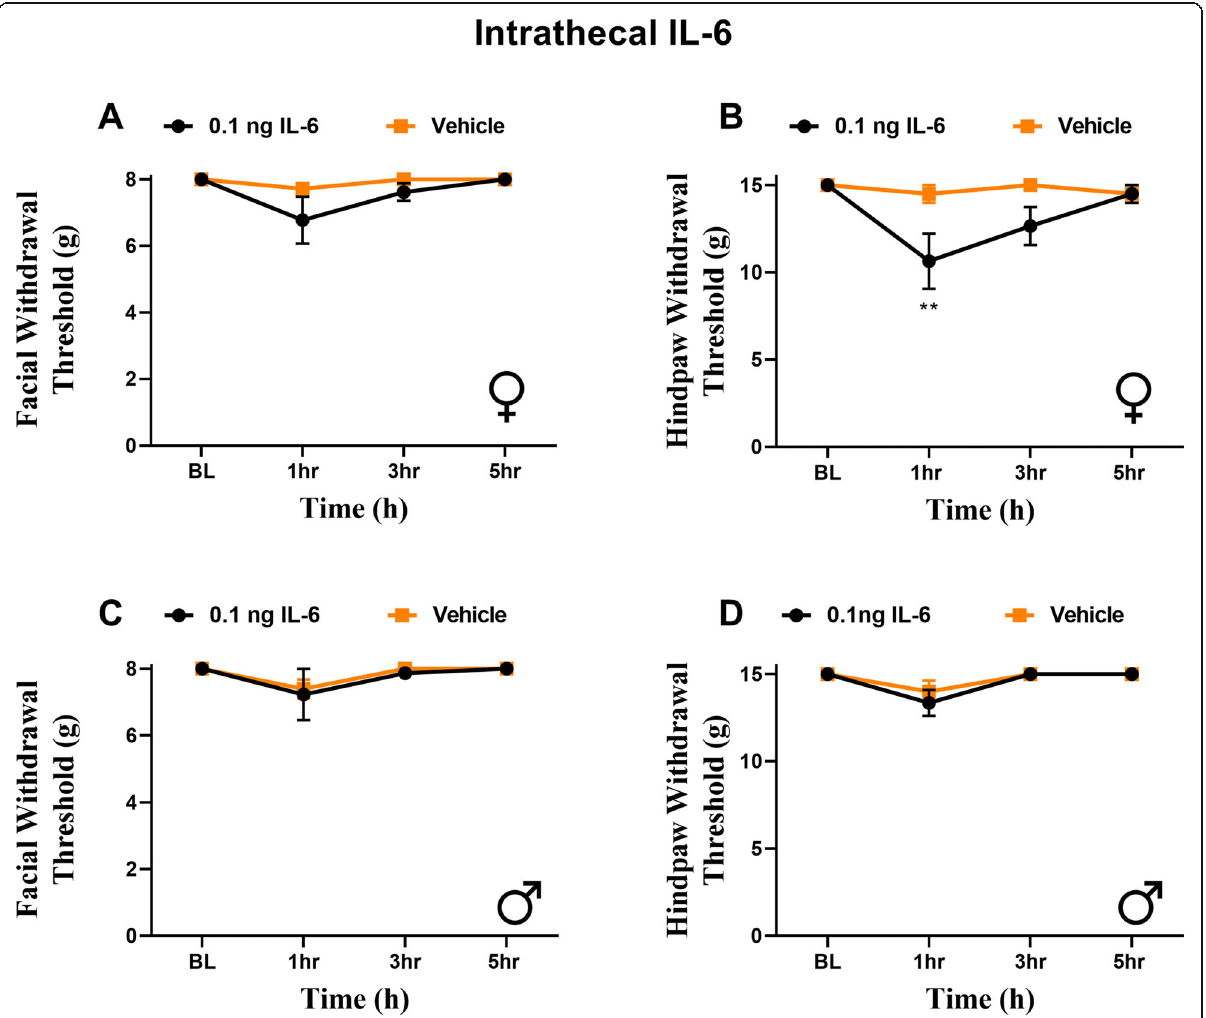
Fig. 7 Intrathecal IL-6 produces hindpaw responses in female, but not male rats. Rats had periorbital and hindpaw withdrawal thresholds assessed prior to and following intrathecal administration of 0.1 ng IL-6 (6 females, 6 males) or vehicle (6 females, 6 males). Two-way ANOVA followed by Bonferroni posthoc analysis revealed no significant effect of treatment on facial responses in female ( A , B ) (F (1, 40) = 2.924, p = 0.0950) or male ( C , D ) rats (F (1, 40) = 1.280, p = 0.7223). Female rats demonstrated significant hindpaw allodynia. (F (1, 40) = 8.700, p = 0.0053) ** p <